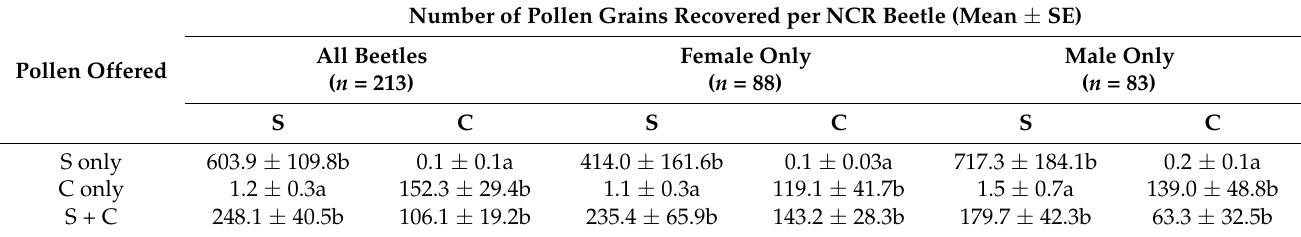
Table 1. Amount of sunflower and corn pollen recovered from lab-reared NCR